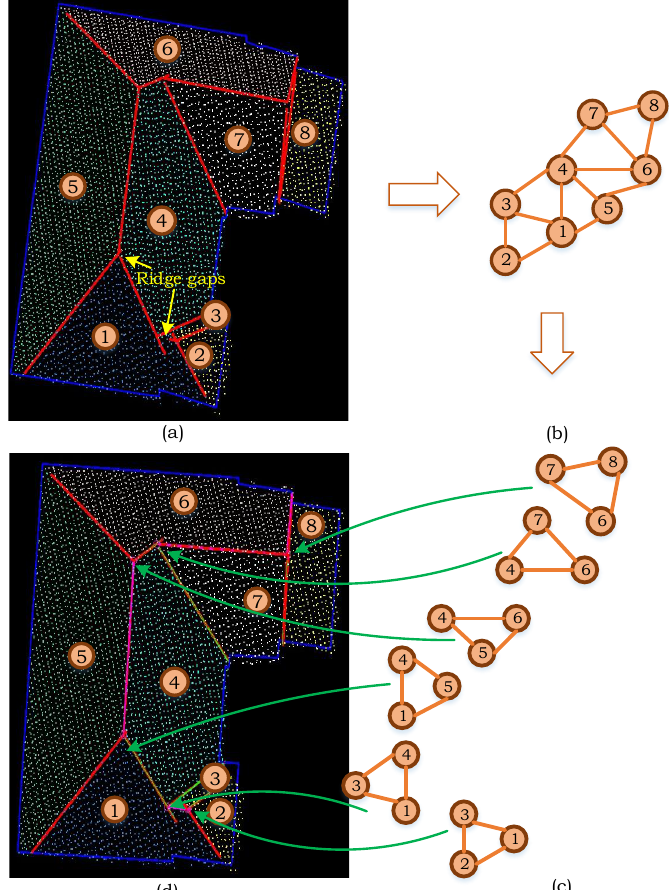
Figure 4. Determination of ridge intersection points: ( a ) roof planes and ridge (intersection) lines;